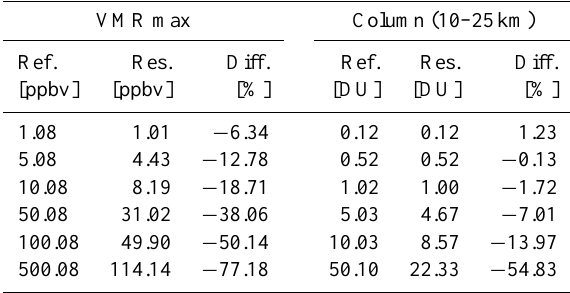
vmr values of SO 2 at the profile maximum and the integrated col- umn amounts between 10 and 25km are reported (Ref. is reference, Res. is result, Diff. is difference = (Res. − Ref.) / Ref. × 100). VMR